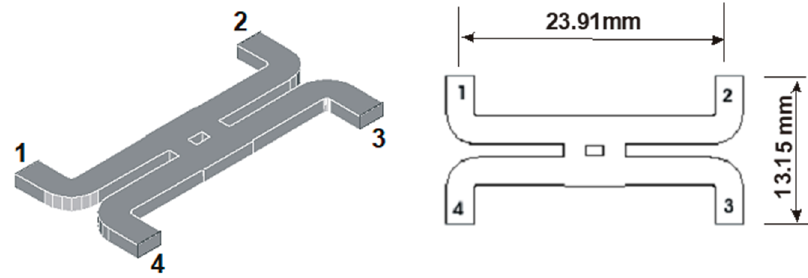
Figure 4. The layout of the 90° hybrid coupler fabricated in a brass block.